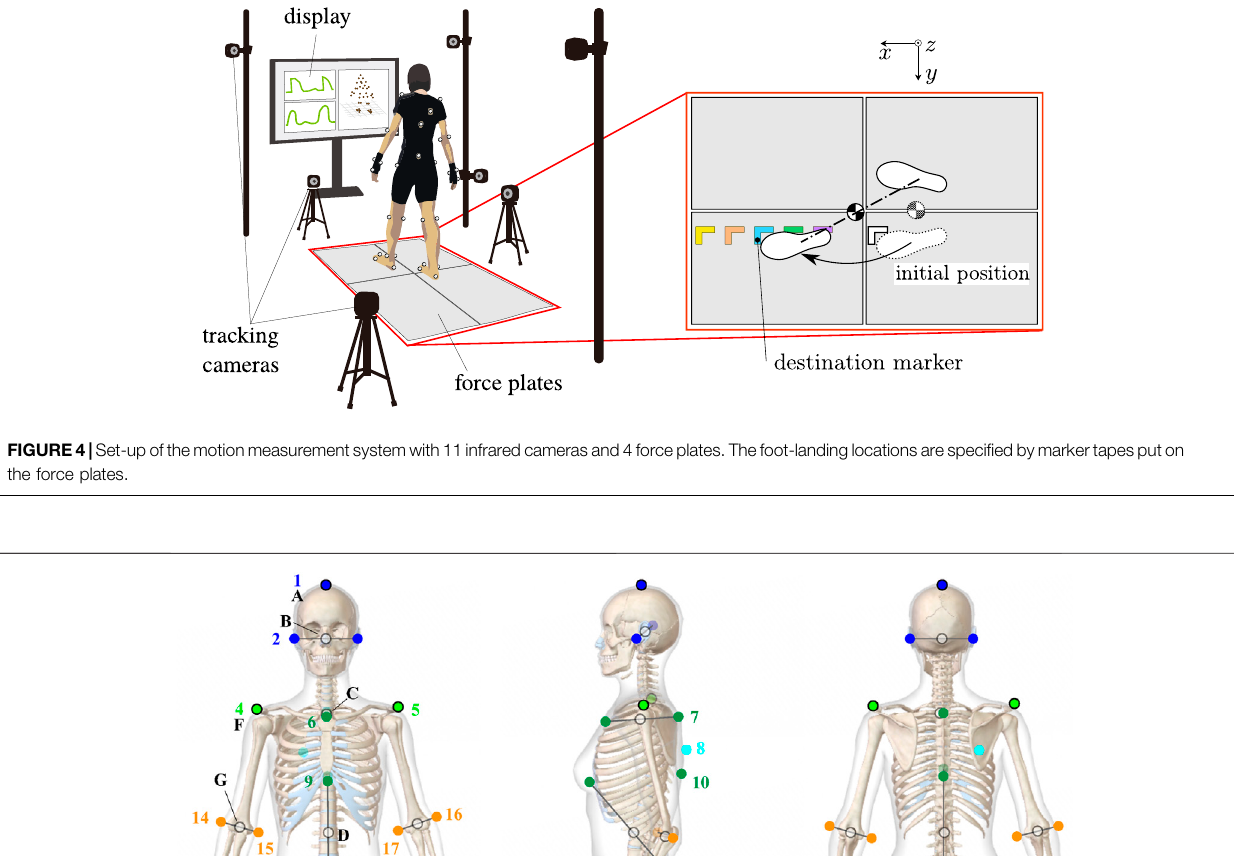
Frontiers in Robotics and AI |